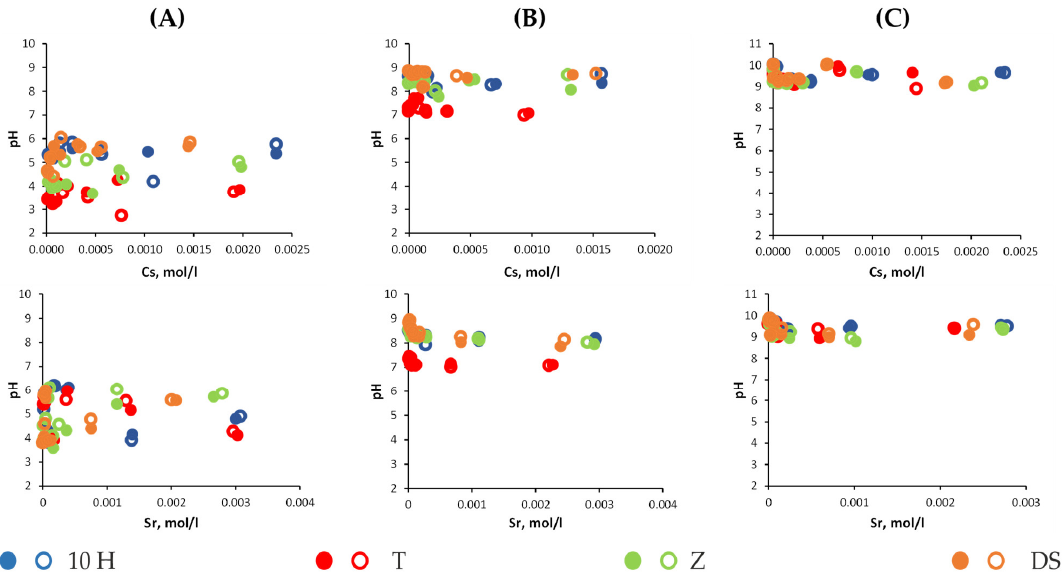
Figure 1. pH dependence on the concentration of Cs(I) or Sr(II) in the equilibrium solution under the experiments at pH of the initial solution 3 ( A ), 7 ( B ), and 10 ( C ) with bentonites 10H, T, Z, and DS. Empty and filled icons are replications of the experiment.